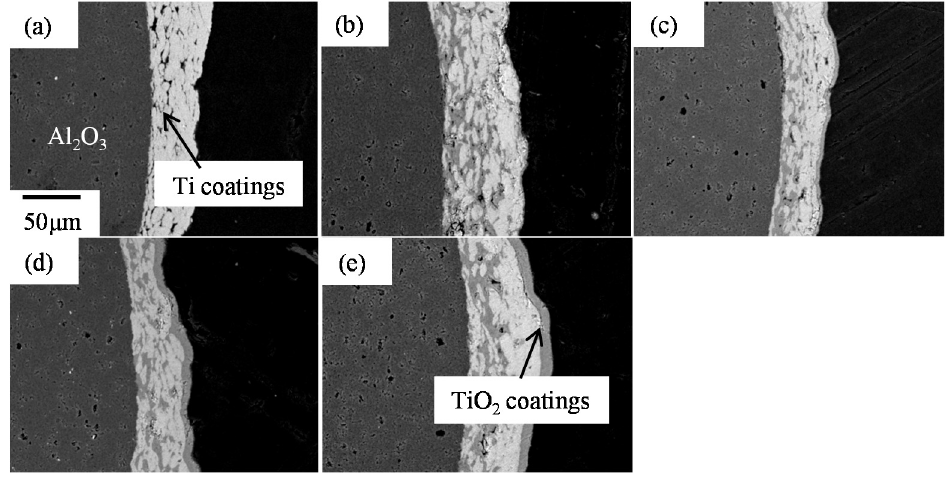
Figure 35. Cross-section SEM images of M10-973 K- y h samples. ( a ) before oxidation, ( b ) 3 h, ( c ) 10 h, ( d ) 30 h and ( e ) 50